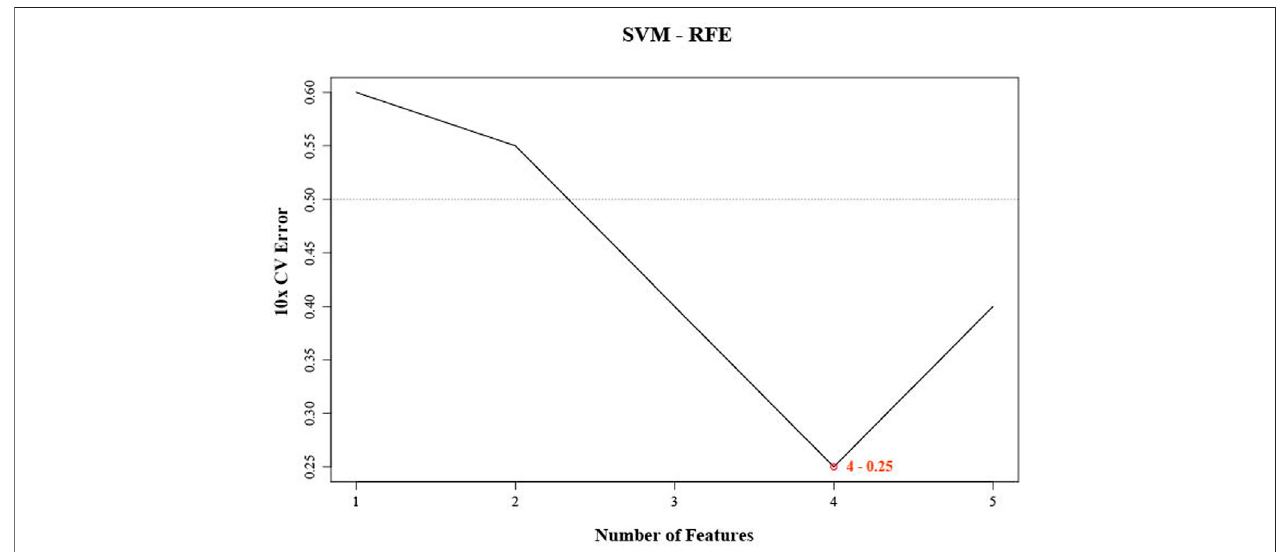
FIGURE1| SVM-RFE wereused forfeature selection.Thepoint highlighted indicates thelowest errorrate,and thecorresponding miRNA atthispoint arethebest signature selected by SVM-RFE.